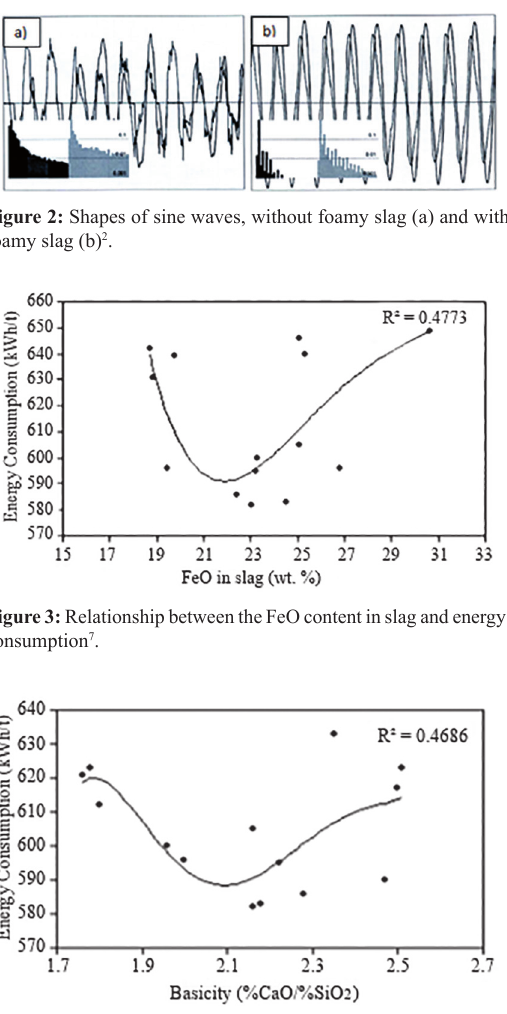
Figure 4: Relationship between basicity and energy consumption 7 . charge has a controlled chemical composition because it is used to produce a critical steel quality. Thus, the dispersion of both the chemical composition and the operational process variables were minimized so that the results by the high variability of parameters that are being considered in this study are